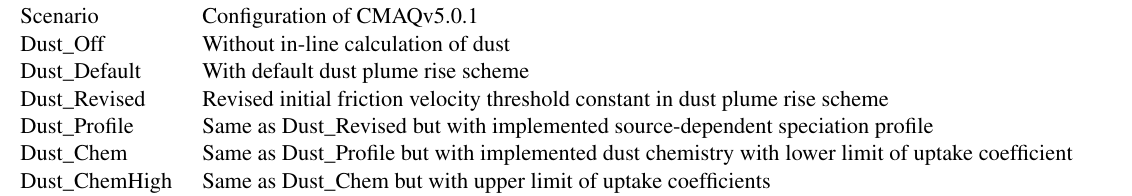
Table 4. Simulation design.